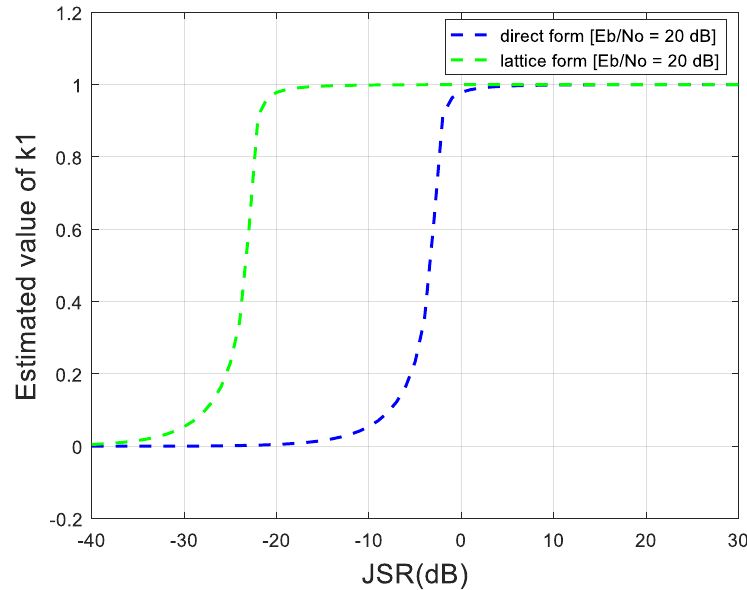
Figure 22. The estimated optimal k1 vs. JSR.